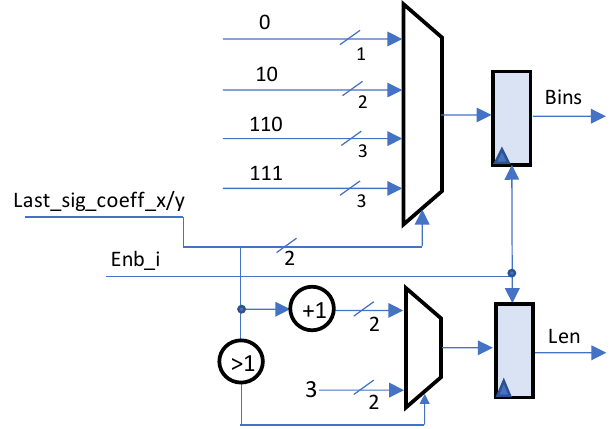
Figure 8. Truncated rice binarization hardware architecture for X or Y coordinates.